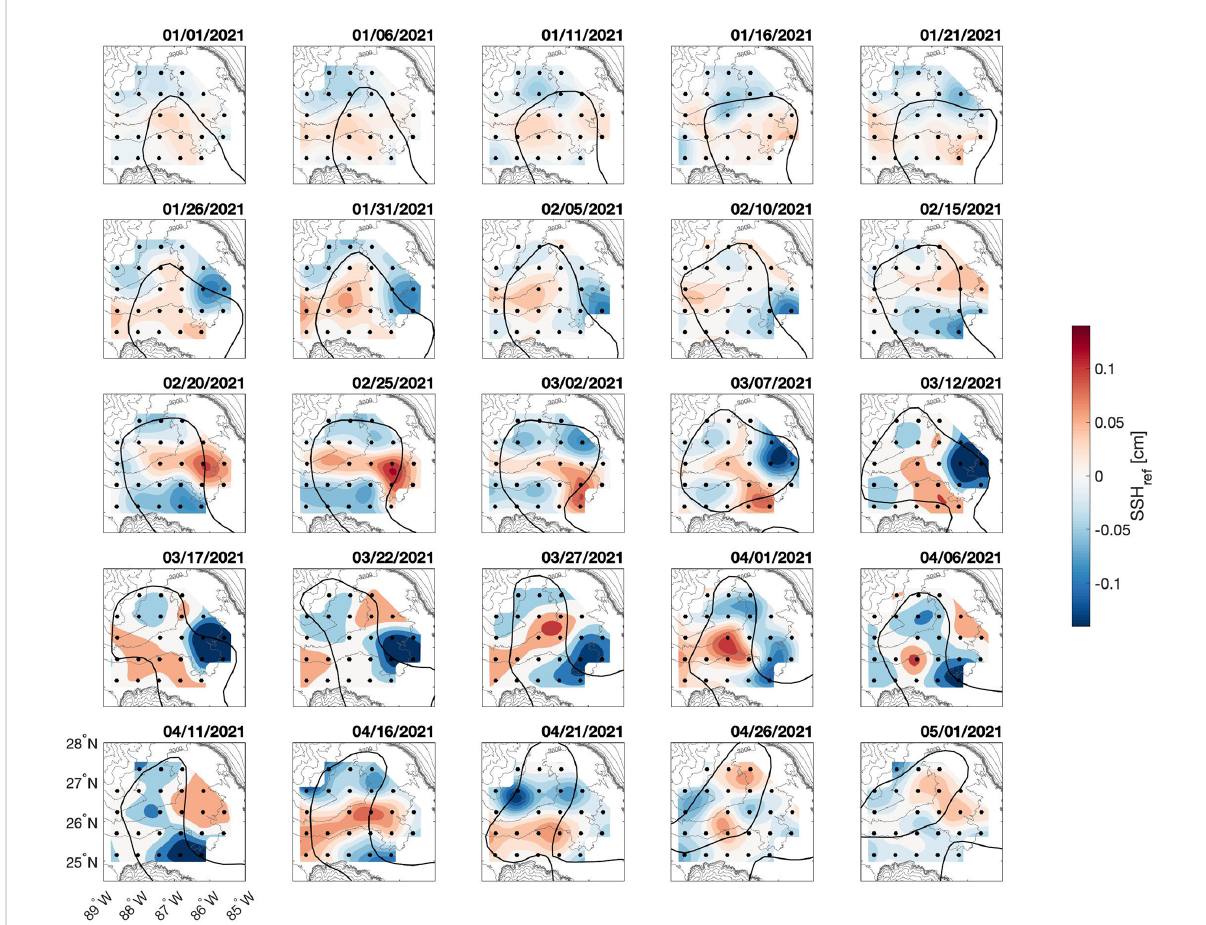
FIGURE 3 Mapped deep pressure fi elds SSH ref at fi ve-day intervals during LCE Ursa shedding event, January-May 2021. The bold SSH contour represents the location of the LC at each time step. CPIES locations are marked by black circles and bathymetry is contoured in light gray every 250